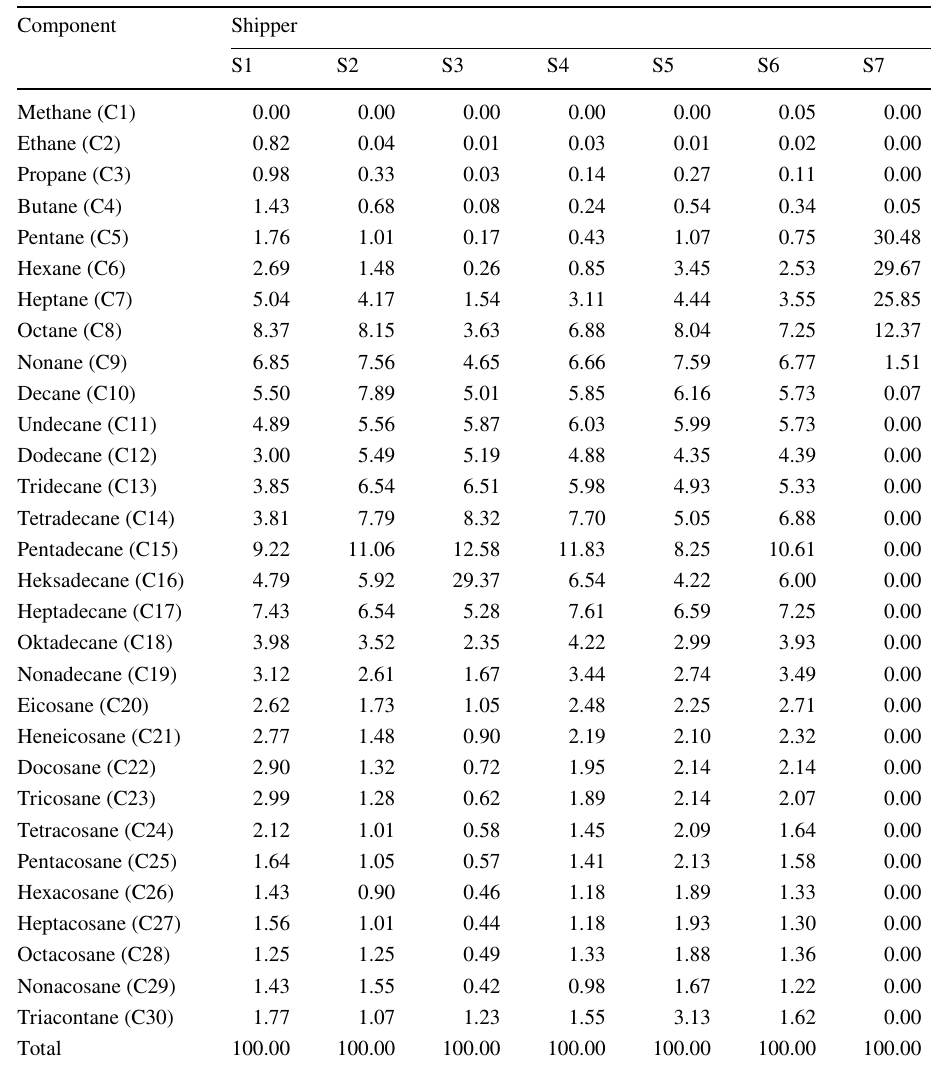
composition (%-mol)